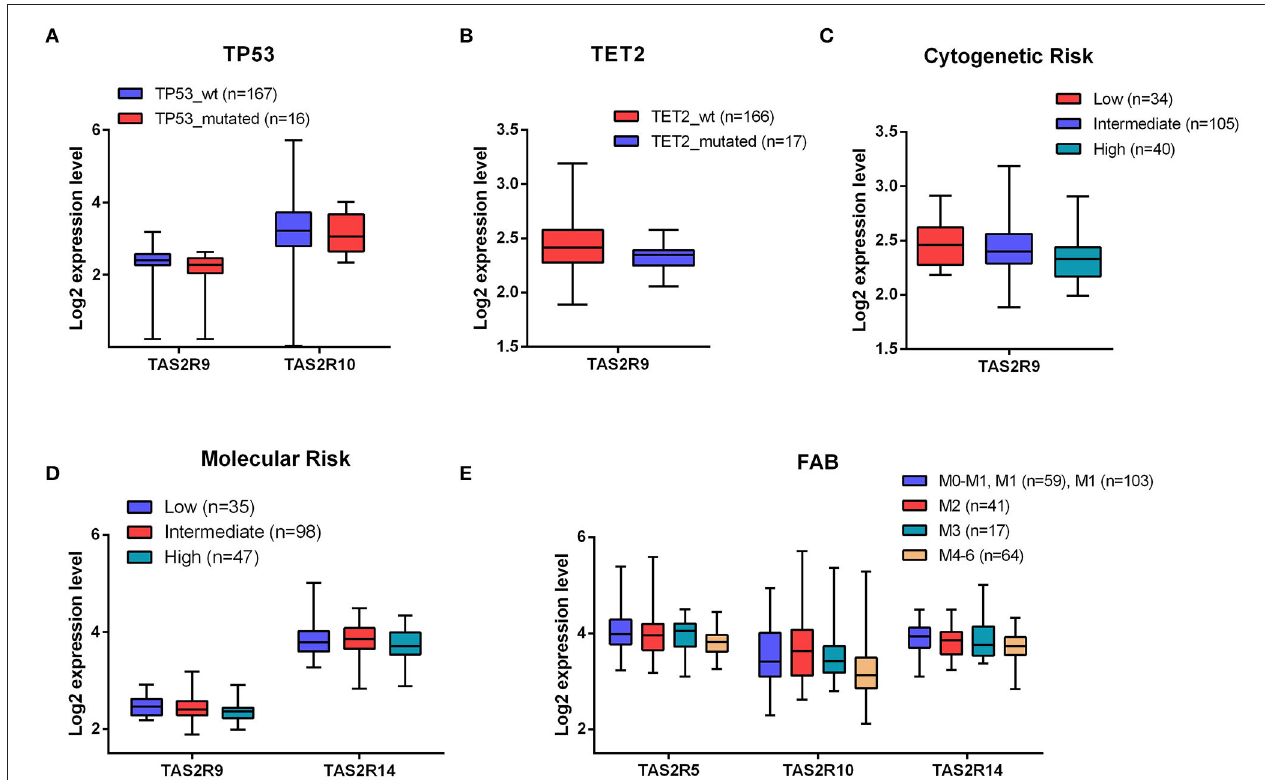
FIGURE 2 | Association between TAS2R transcript levels and clinical parameters in AML patients. (A,B) Boxplots of different expression level of TAS2R10 and TAS2R9 in TP53 and TET2 mutated and wild-type samples; (C–E) Boxplots of the indicated TAS2Rs based on Cytogenetic molecular and FAB clinical features. Statistical analysis were performed by Student’s t -test and Benjamini–Hochberg adjusted p -values correction.